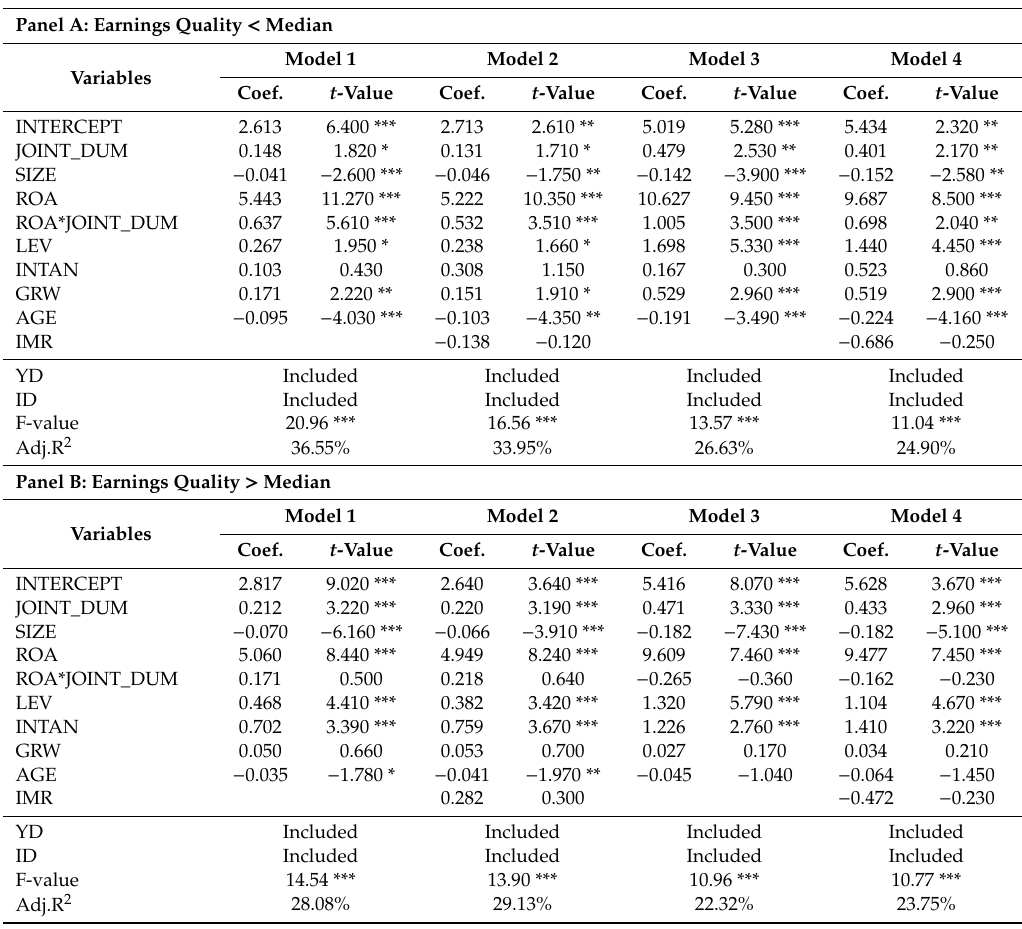
Table 15. Analysts’ cash flow forecast issuance and firm